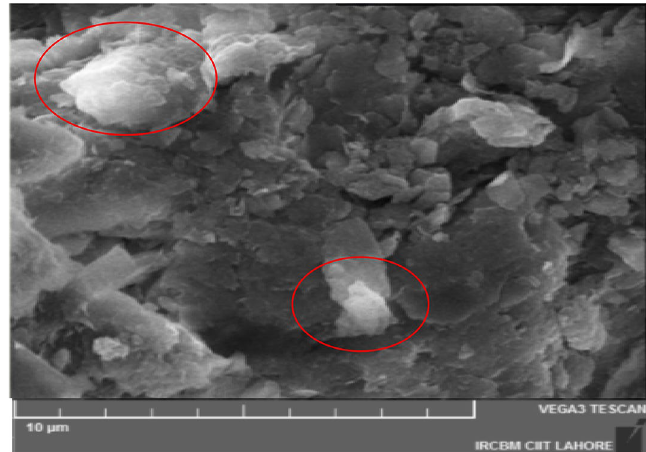
Figure 6. SEM micrograph of Ag–GO nanocomposite.